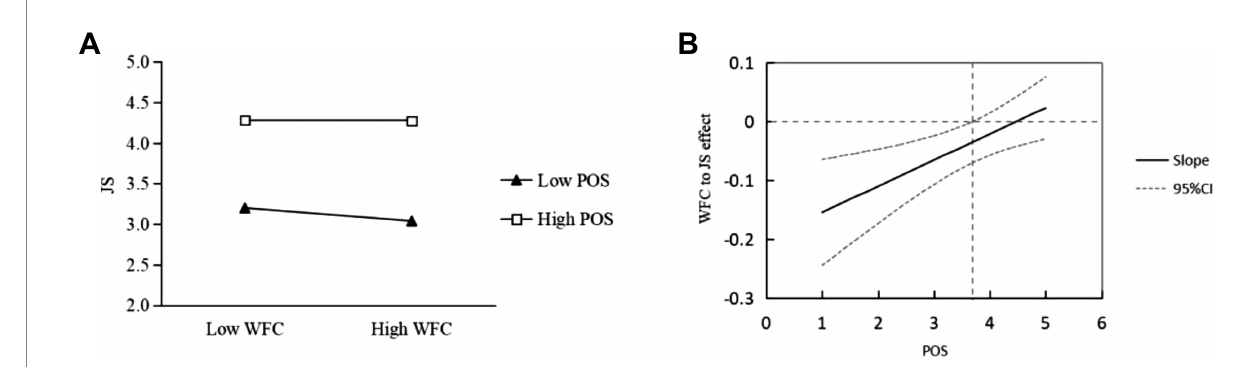
FIGURE 3 Moderating effect of POS on the relationship between WFC and JS A : Simple slope test of moderating effect B : Johnson-Neyman analysis of moderating effect.